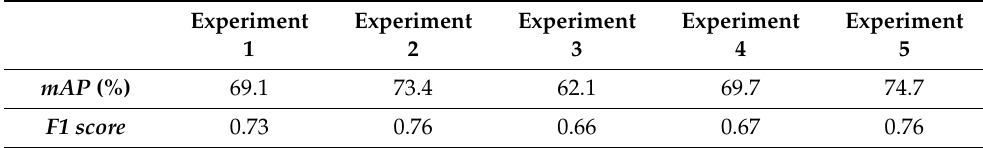
Table 17. Results of YOLOv5-TDHSA on CCTSDB2021 dataset.